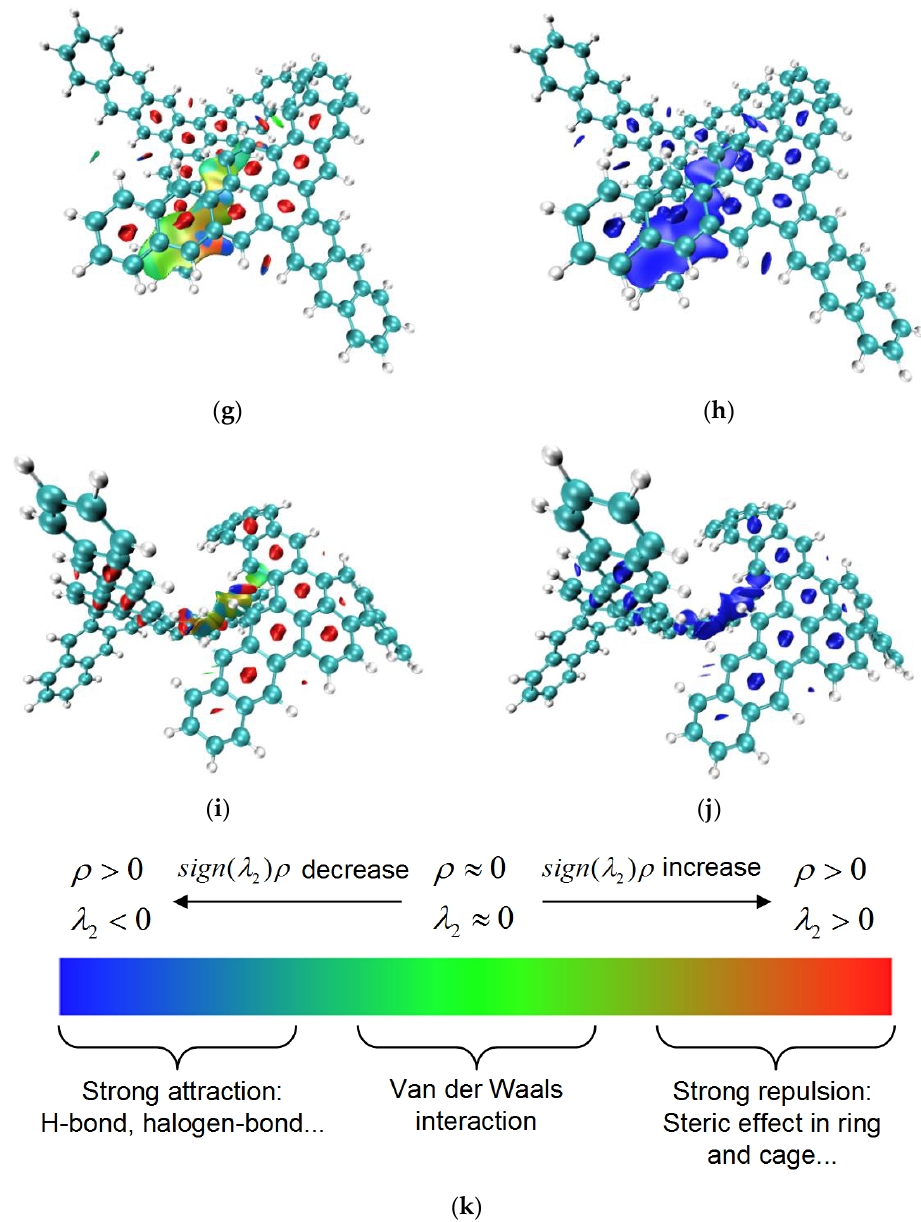
Figure 8. The results of aRDG ( a , c , e , g , i ) and TFI ( b , d , f , h , j ) analysis of three kinds of asphaltene molecules. The colors identify the types of interactions ( k ).